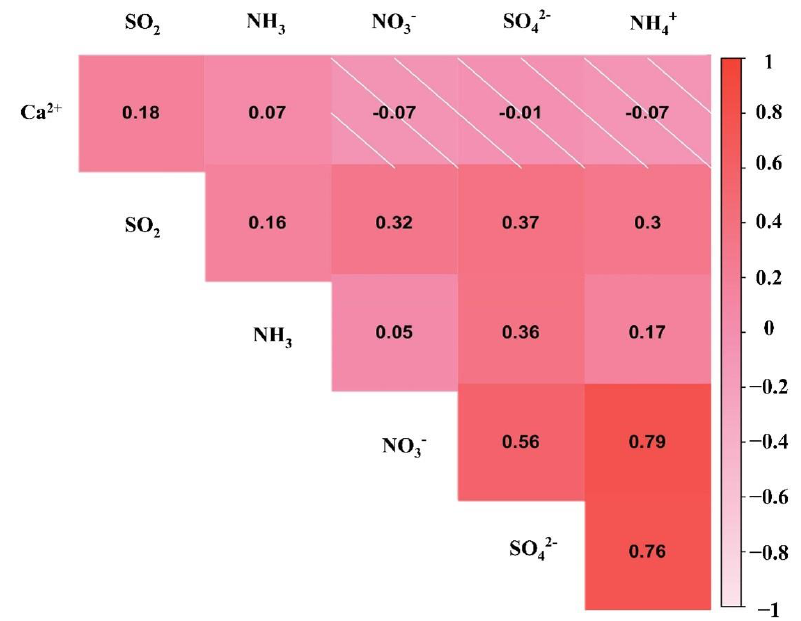
Figure 5. Water-soluble ion correlation heatmap in Wuhan City.